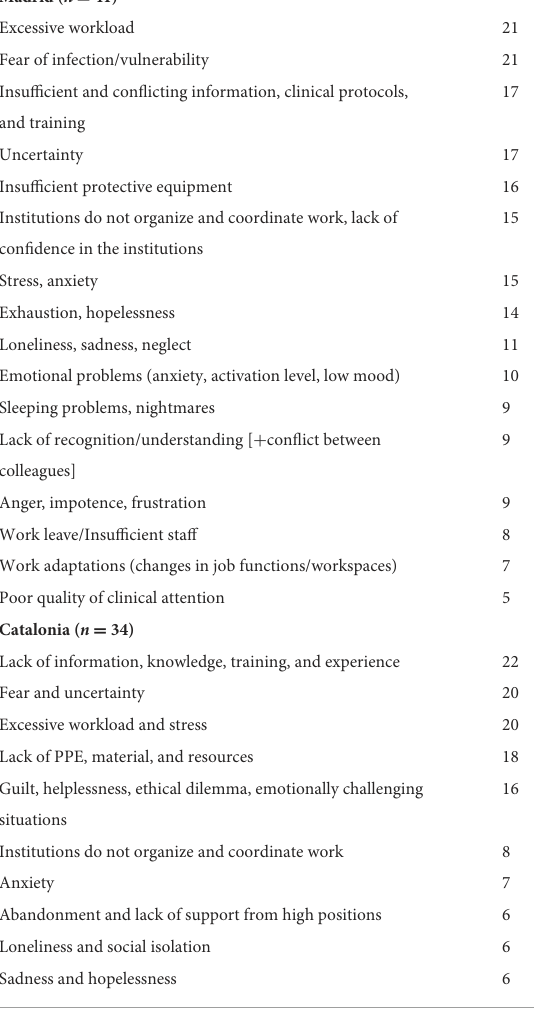
TABLE 3 Frequency of problems reported by FL